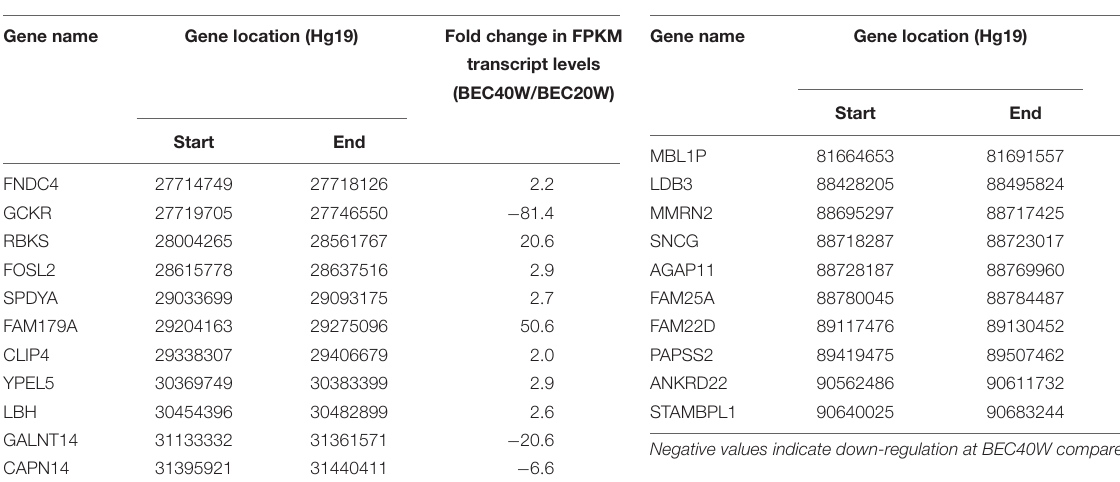
TABLE 3 | List of known genes on 10q22 locus with more than twofold change in transcript levels between BEC20W and BEC40W cells, as represented in Figure 4 .